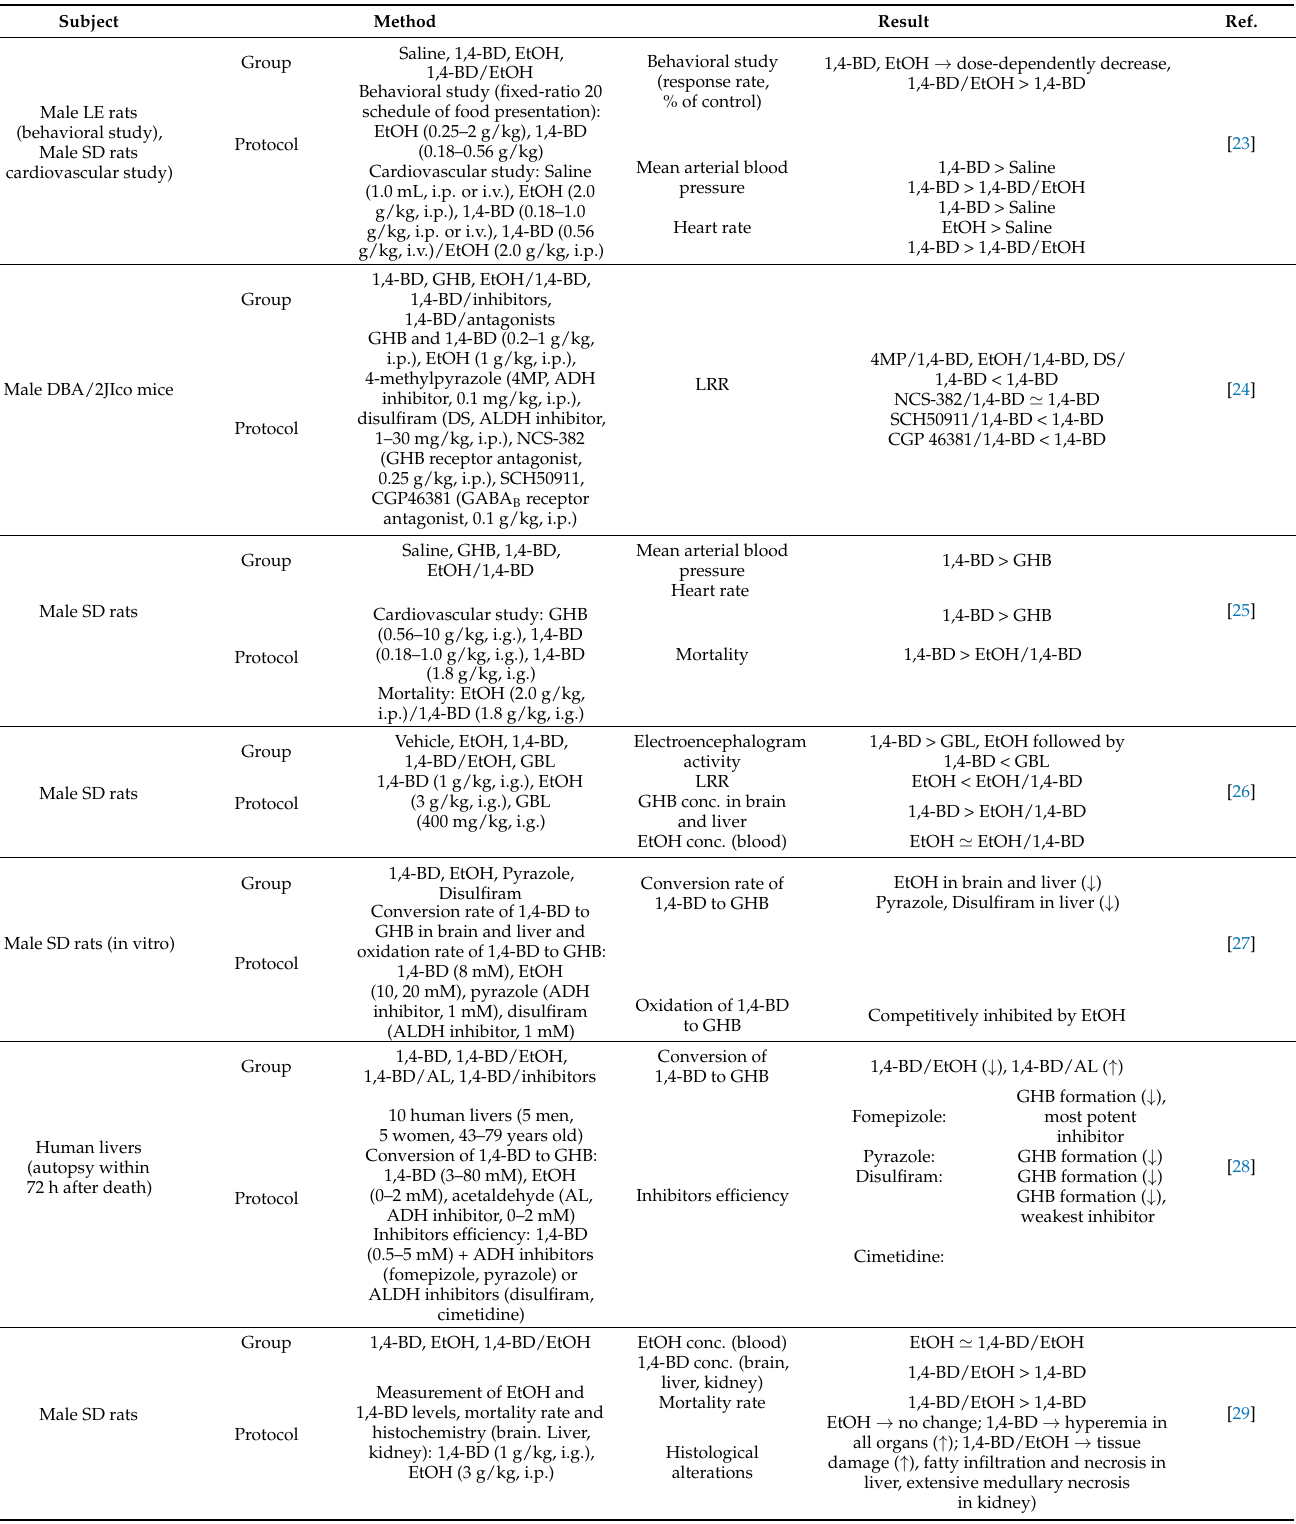
Table 4. Animal and in vitro studies on toxicokinetic and toxicodynamic changes in 1,4-butanediol following co-administration of